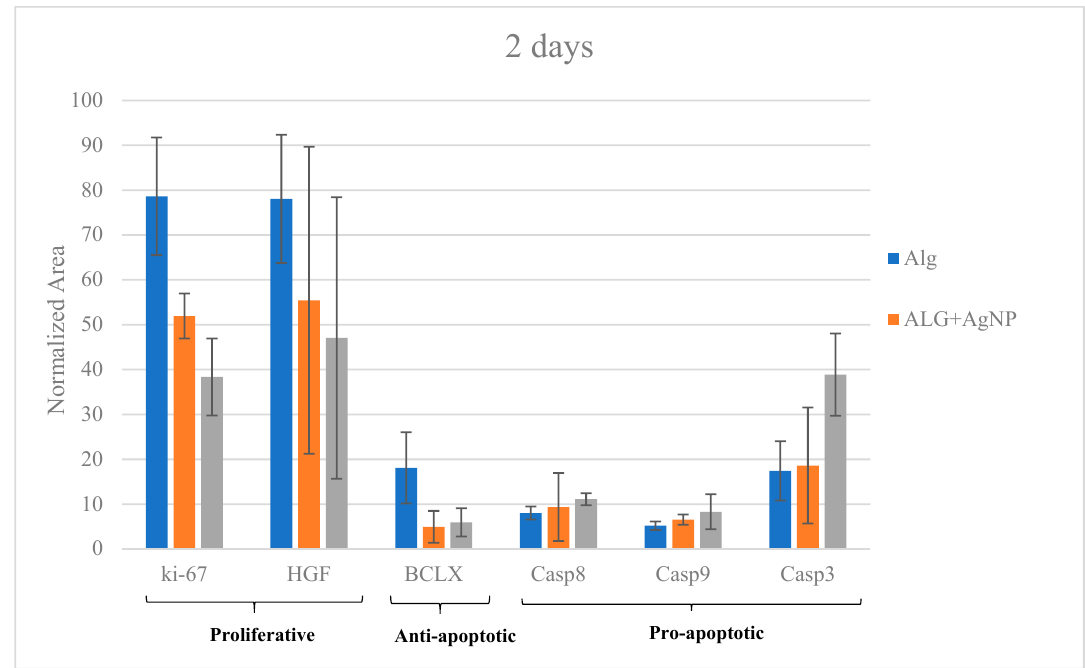
Figure 7. Liquid chromatography-electrospray tandem mass spectrometry ( LC-ESI-MS/MS) SRM targeted protein expression at day 2.